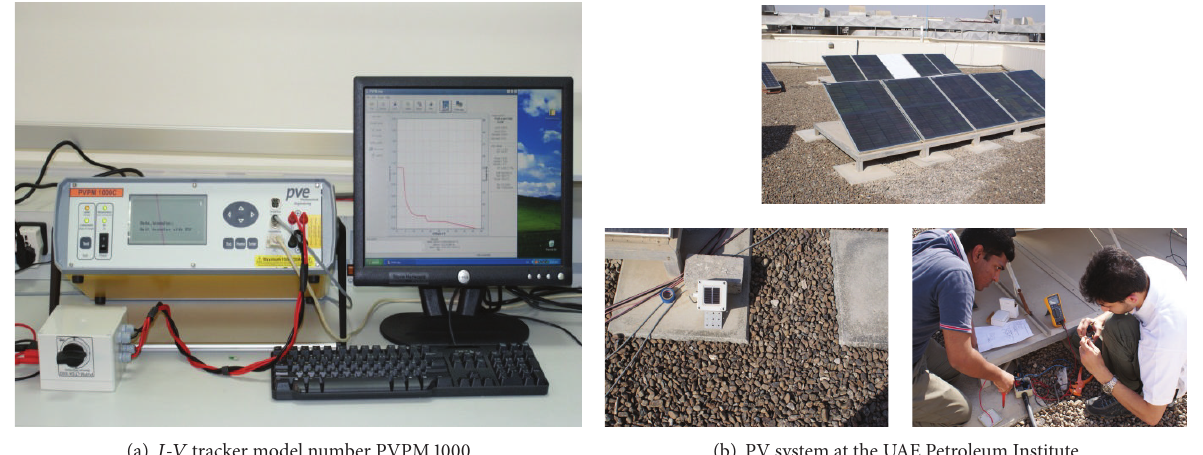
Figure 6: Pictures of the 𝐼 - 𝑉 tracker and actual PV system used at the UAE Petroleum